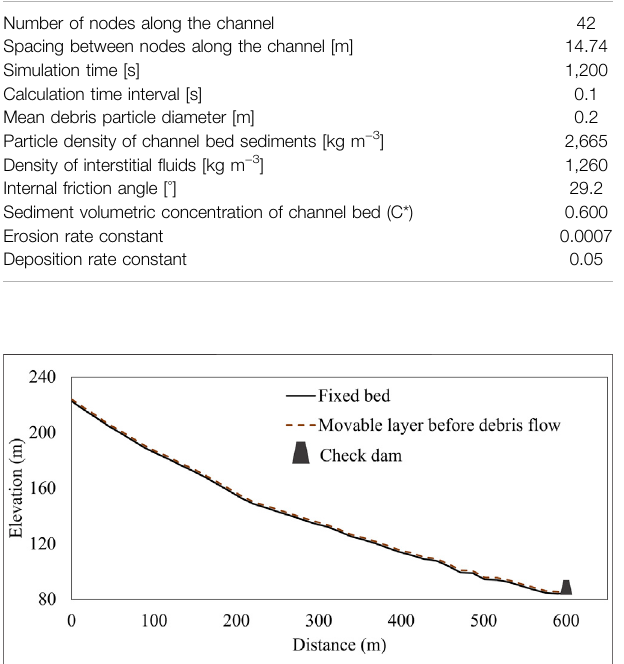
FIGURE2| Schematicdesignofthedebris fl owchannel.Theblacksolid line is the fi xed channel bed, and the brown dashed line is the erodible layer. The location of the check dam is represented as a black trapezoid.